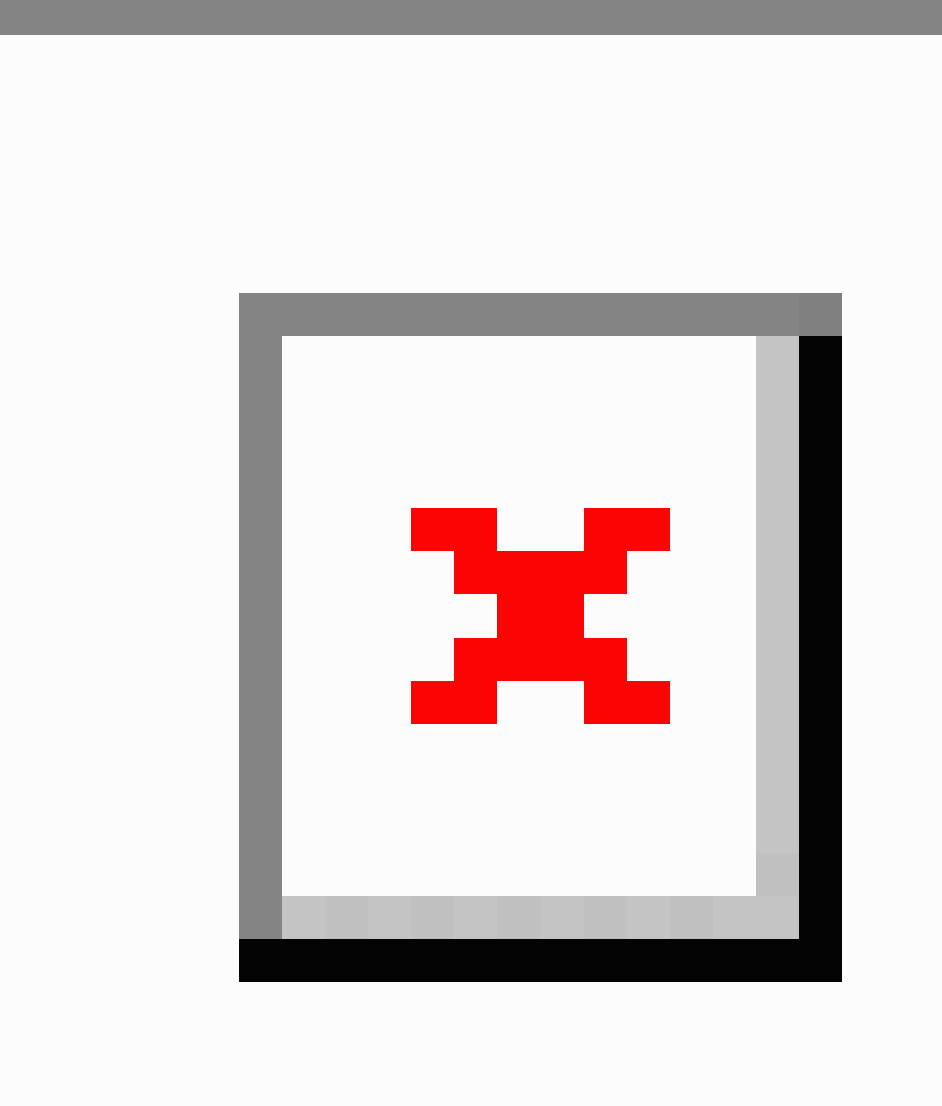
Figure 5. Short-term effectiveness of Web-based interventions on stress symptoms compared with that of a control